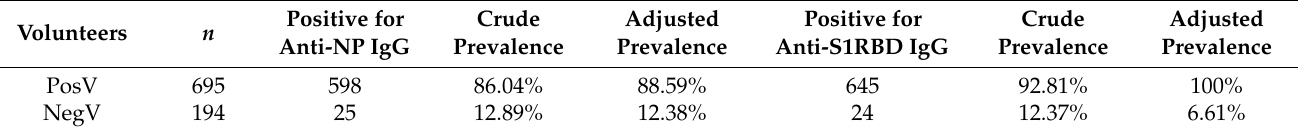
Table 2. Crude and adjusted prevalence of NP and S1RBD IgG in volunteers who tested nega- tive/were unknown (NegV) ( n = 194) and those who tested positive (PosV) ( n = 695) for SARS-CoV-2. Adjustment calculations are based on the sensitivity and specificity of the kits used as provided by the